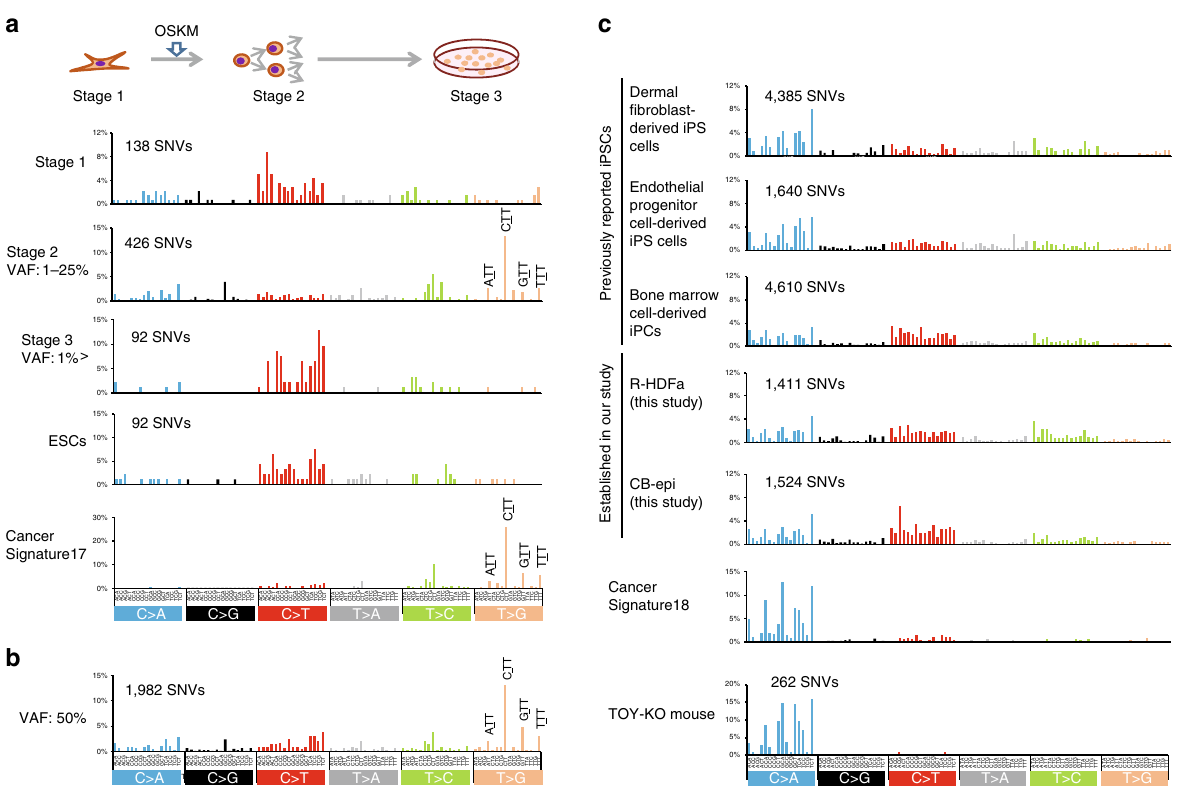
Fig. 6 A cancer mutational signature exists in mouse reprogrammed pluripotent stem cells. a For cancer mutational signature analysis, SNVs were divided into 96 classes in accordance with the base substitution pattern and fl anking nucleotides 39 . The Y -axis shows the percentage of mutations attributed to a speci fi c mutation type. (Upper) Timeline of iPSC generation: pre-stage (stage 1); mid-stage (stage 2); and post- stage (stage 3) reprogramming states. (Lower) Mutational signature at each step: (stage 1) pre-existing SNVs that have been reported as background mutations in parental cells 3 ; (stage 2) point mutations that arose just after the onset of cell lineage conversion during iPSC generation, i.e. bona fi de de novo variations (Fig. 5: 1 – 25% VAF); and (stage 3) point mutations that arose during prolonged culture (Fig. 5: 1% > VAF). The ESC results identifying SNVs in four mouse ES cell populations (B6ES2-2, B6ES2-7, B6ES2-9, and B6ES2-11) 4 , and cancer mutational signature 17, are also shown 39 . b Mutational signature for the 50% VAF-SNVs in the R-4F-17, R-4F-28, and 2A-4F-136 iPSC lines, comprising 1982 SNVs in total (847, 564, 571 SNVs in R-4F-17, 2A-4F-136, and R-4F- 28, respectively, which are indicated in the Venn diagrams shown in Fig. 5b). The 50%VAF indicates that the SNV exists in all cells within a colony because the mutation has basically arisen in either the paternal or maternal allele, but not both. Such 50%VAF SNVs are the most abundant point mutations in most lines derived from various reprogrammed pluripotent stem cells 3,4,14 . c Mutational signature analysis of human iPSC lines, including those previously reported. Details of human iPSCs are provided in Supplementary Table 2. Cancer Signature 18 has been previously described in various cancers, most notably in neuroblastoma 39 . TOY-KO mice, Mth1/Ogg1/Mutyh triple knockout mice 61